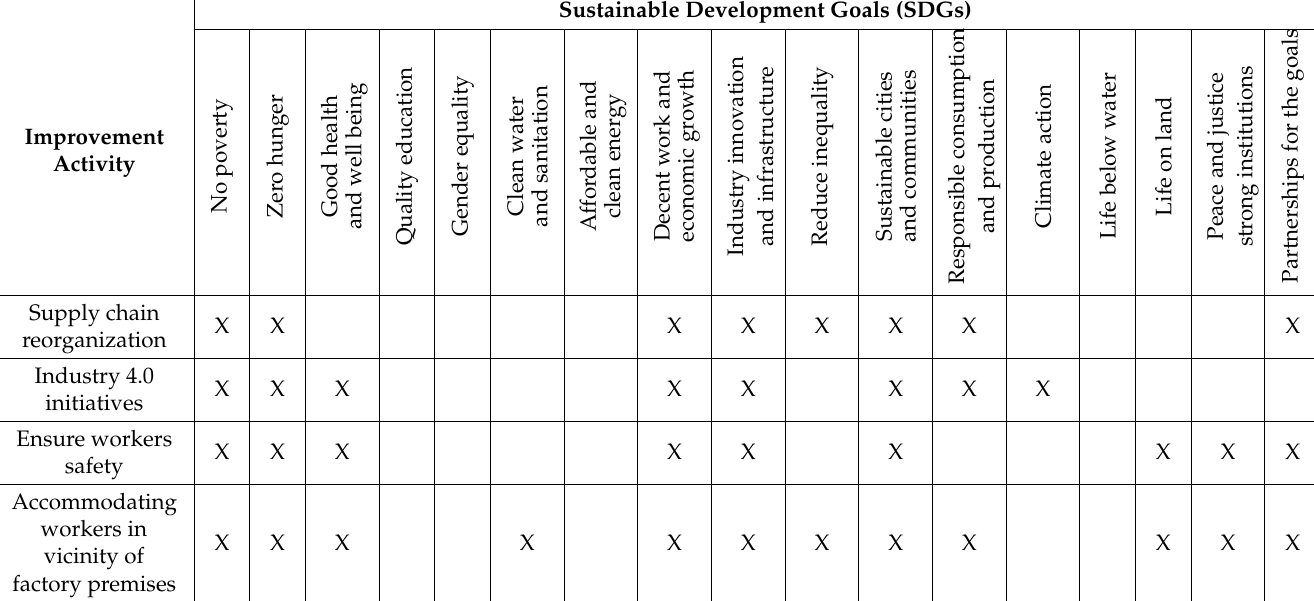
Table A7. Sustainability assessment of proposed improvement